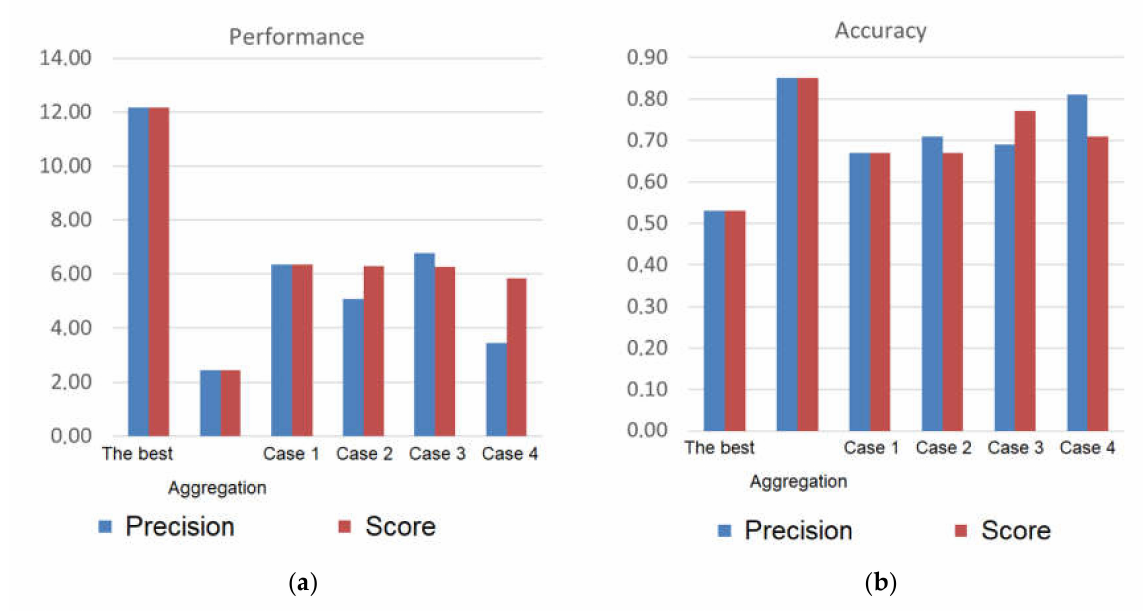
Figure 12. Experimental results: ( a ) performance, ( b )